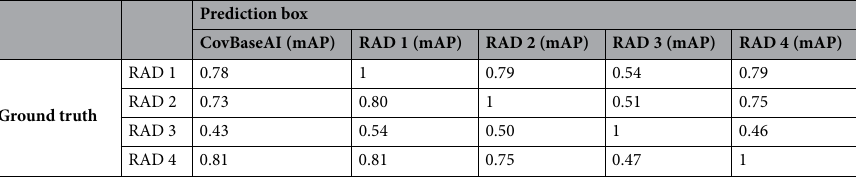
Table 2. Bounding box analysis on 905 CxRs (434 RT-PCR +ve and 471 historical scans) from independent validation datasets. RAD radiologist, mAP mean average